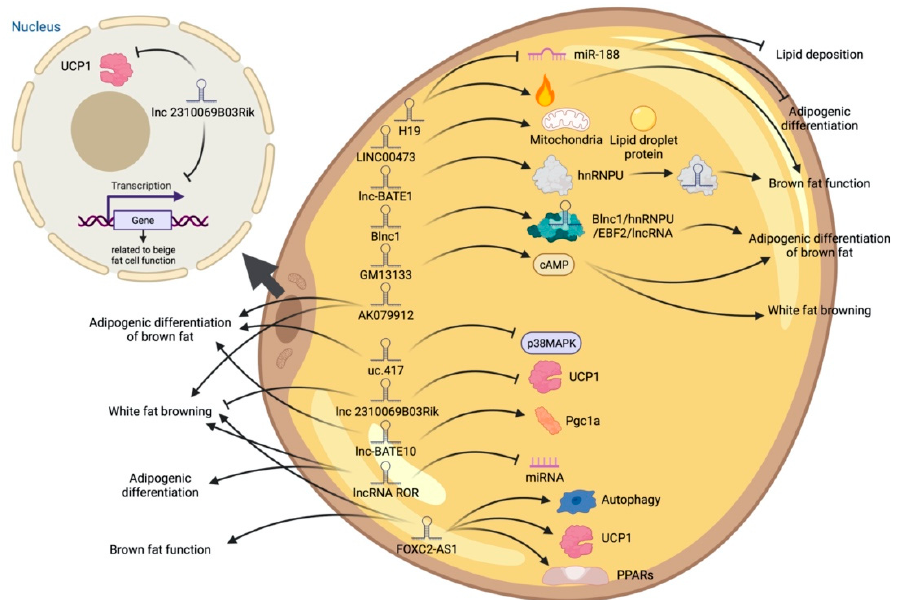
Figure 5. Schematic diagram of the biological function of lncRNA involved in the differentiation of brown adipocytes.